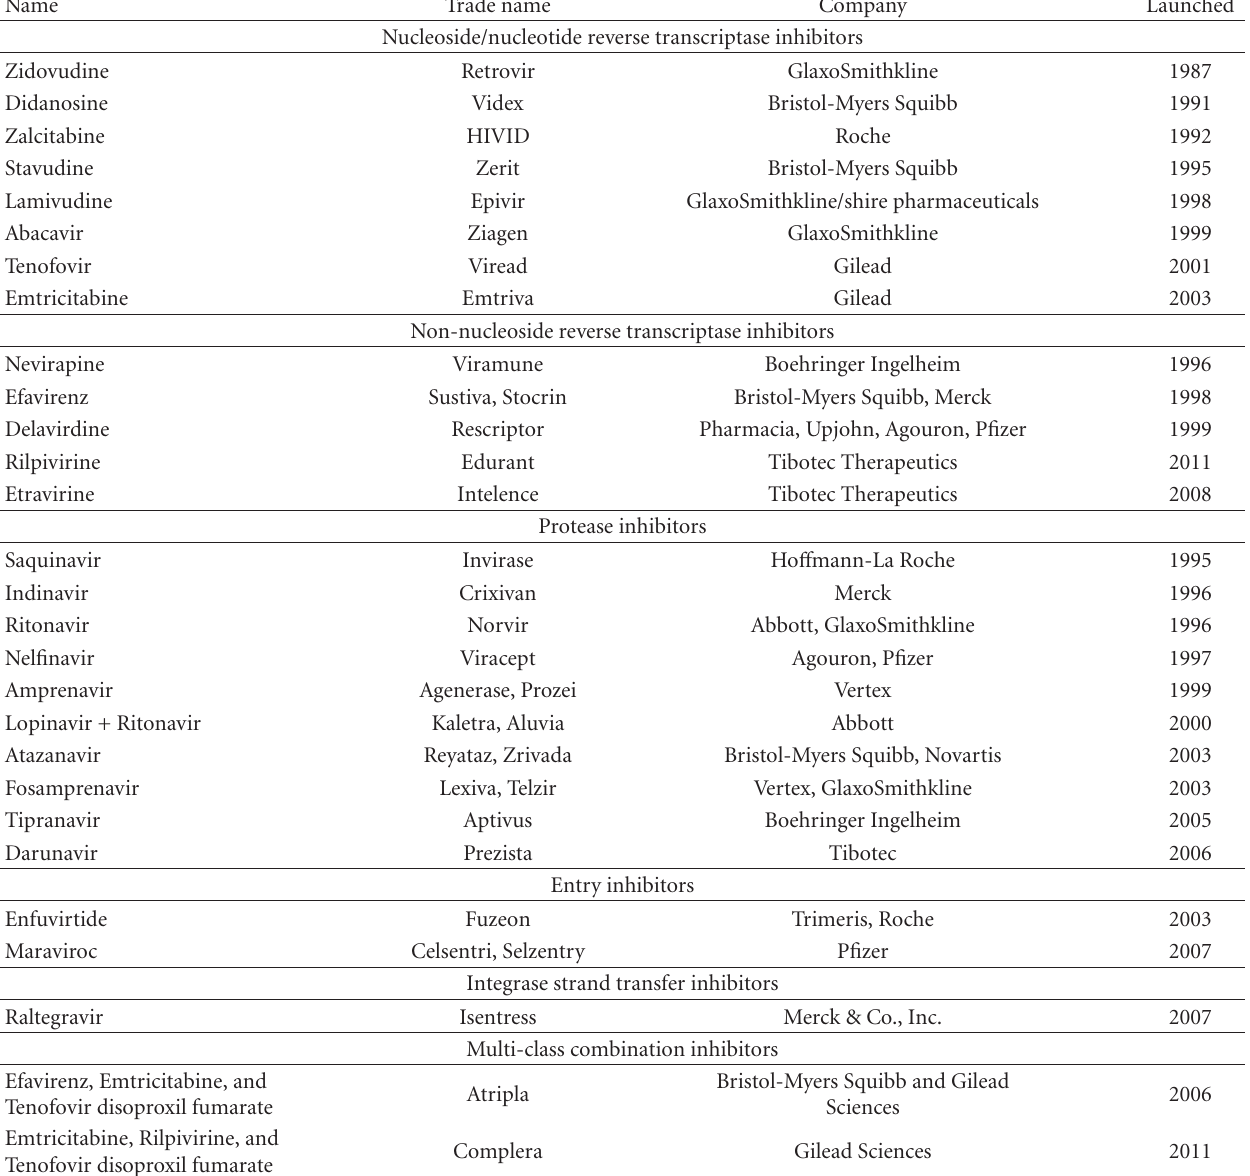
Table 1: Licensed antiretroviral